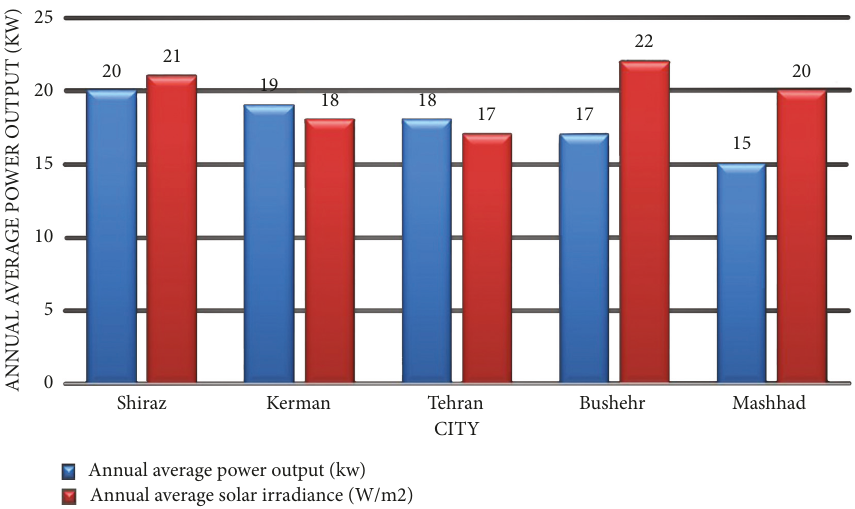
Figure 9: Comparison of average year-on-year power production in different cities of